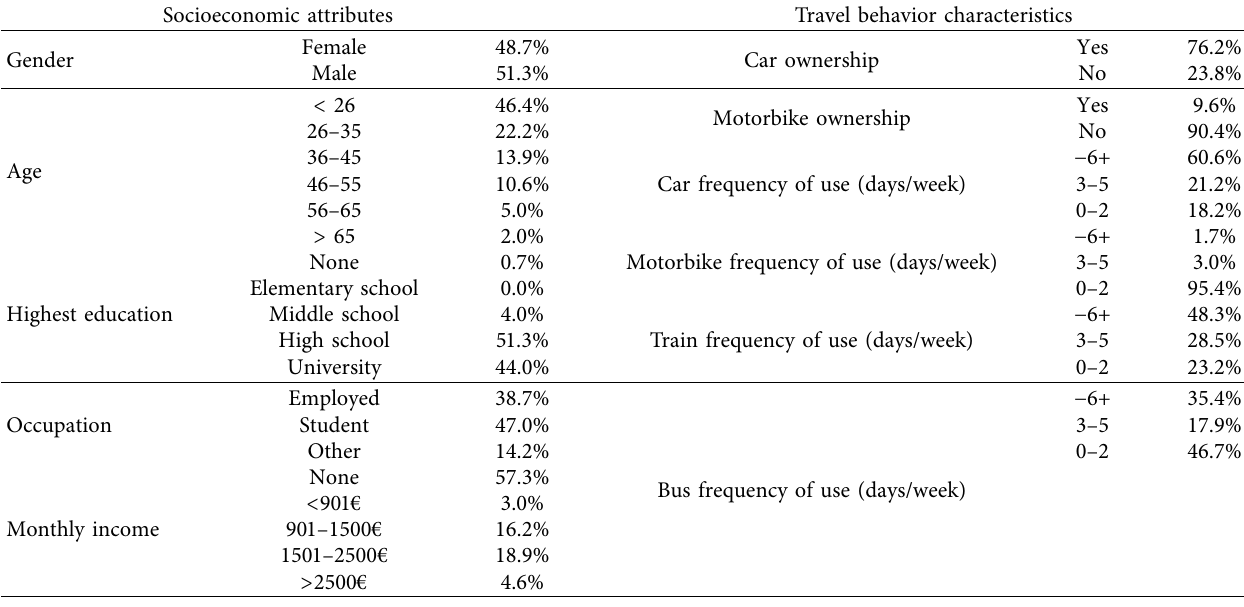
Table 2: Socioeconomic attributes and travel behavior characteristics of the sample.